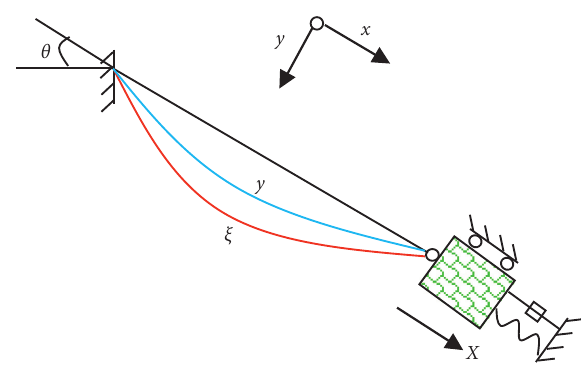
Figure 1: Cable-bridge coupling